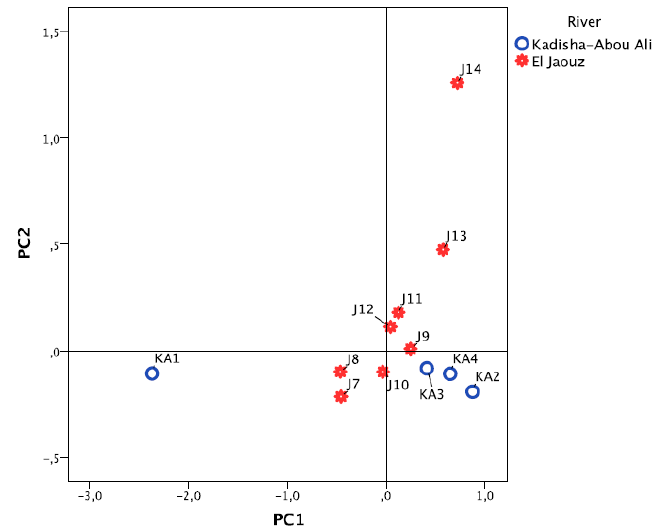
Figure 4. Scatter plot of scores during the study period, corresponding to the first two principal components for all stations excluding KA5 and KA6.